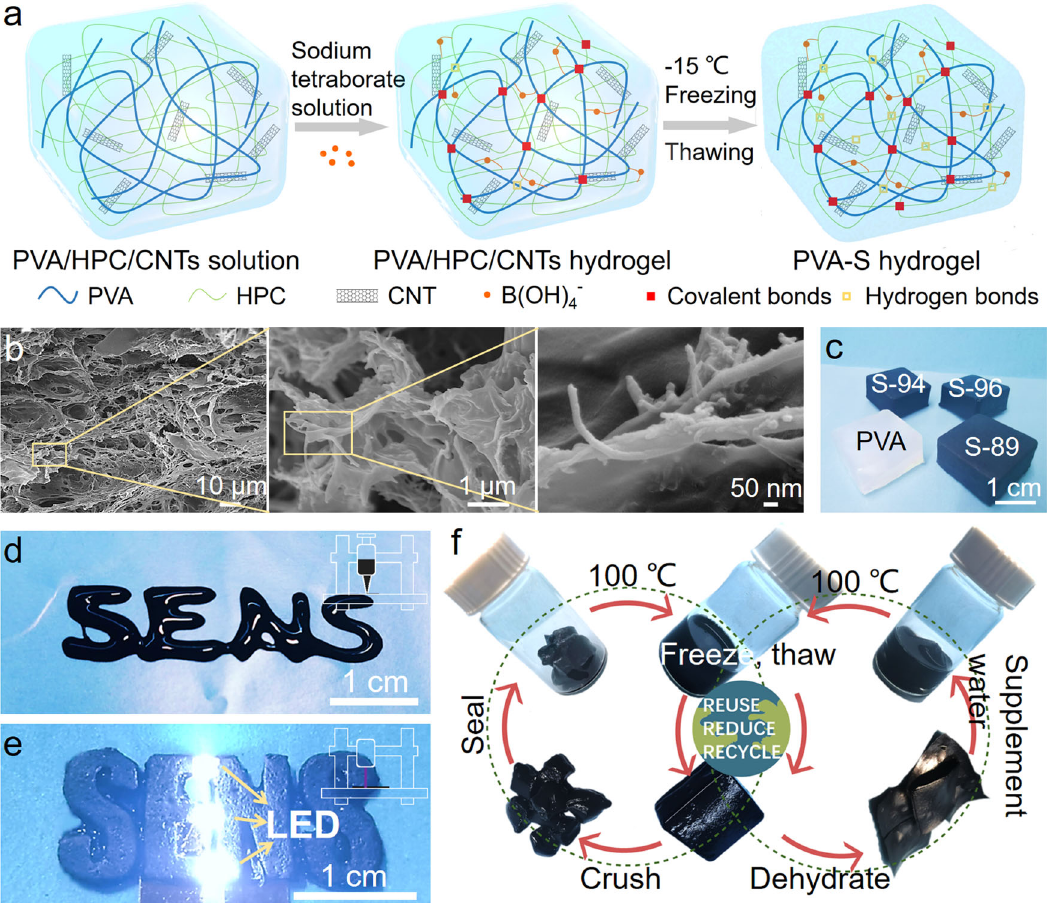
Fig. 1 A tough, self-healing, resilient, conductive PVA-S hydrogel synthesized through a dual-network dual-crosslinking strategy. a Schematic diagrams of PVA-S hydrogel fabrication. b The microscopic structure of the freeze-dried PVA-S hydrogel at various magni fi cations. c Photograph of typical PVA-S hydrogel bulks fabricated by molding. d and e Processability and conductivity. The “ SENS ” fi gurate hydrogels were obtained by DIW 3D printing and laser engraving, respectively. f Recyclability and remoldability. The PVA-S hydrogel fragments (or dehydrated fragments) were fused at 100 °C and